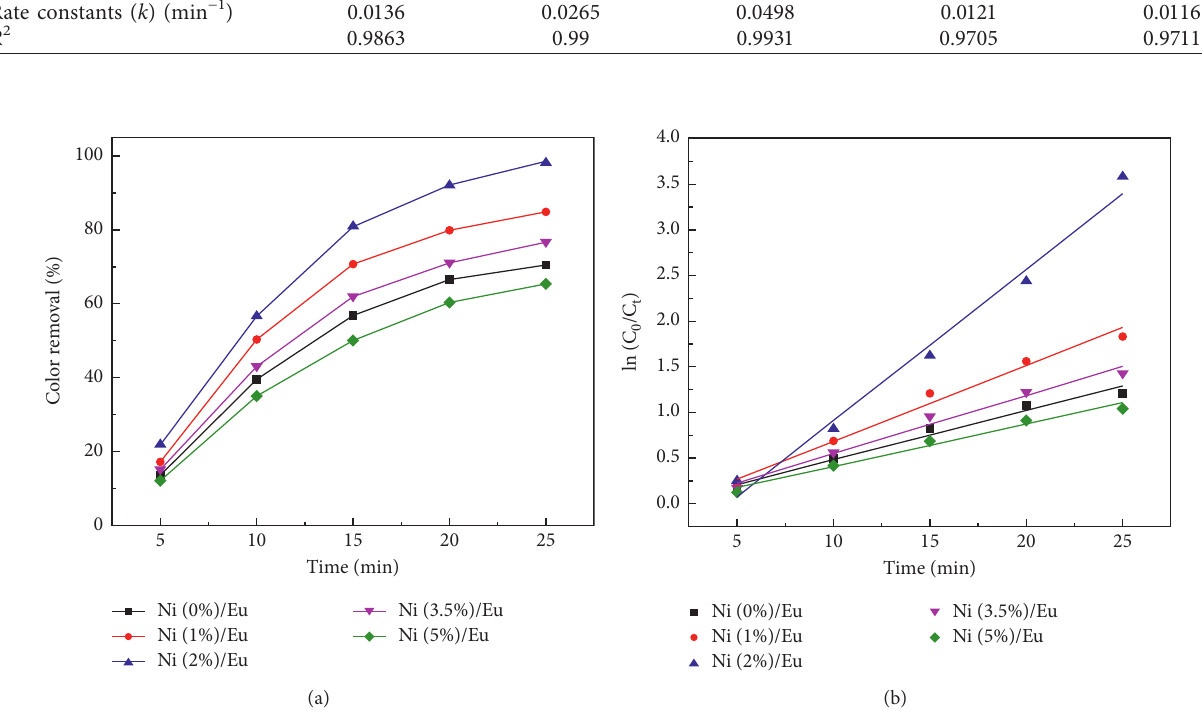
Figure 11: Electrochemical decolorization performance at Ti/SnO 2 -Sb-Ni/Eu electrodes modified with various Ni contents. (a) Decol- orization efficiency. (b) Kinetic analysis of the curves (RhB concentration: 20mg · L − 1 ; current density: 10mA · cm − 2 ; supporting electrolyte: 0.1mol · L − 1 Na 2 SO 4 ; 25 °